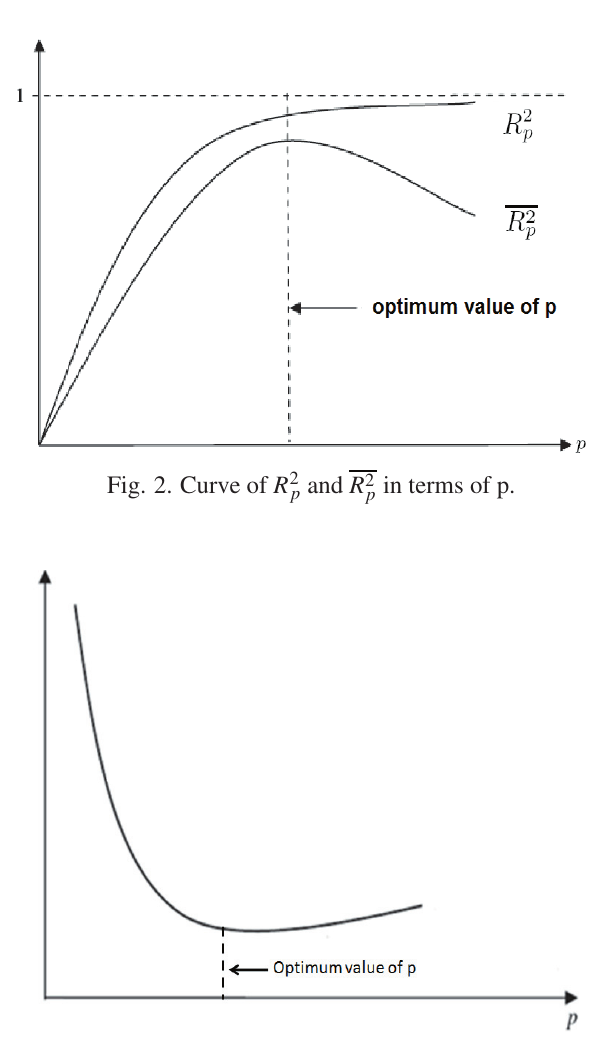
Fig. 3. Curve of MSE p in term of